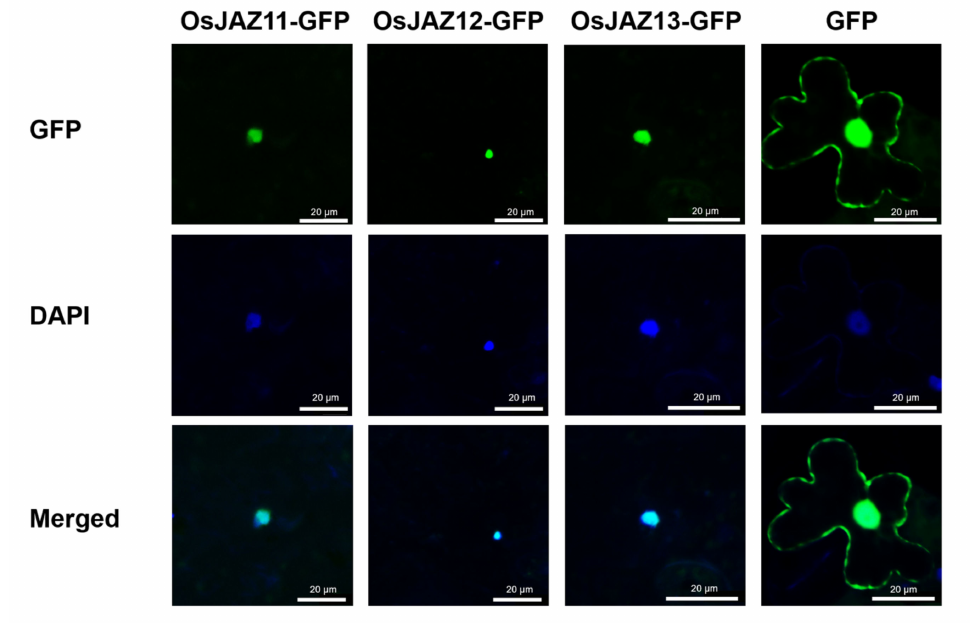
Figure 6. Subcellular protein localization. The fluorescence of the JAZ-GFP fusion protein in the OE plants in the nucleus was observed under a microscope. GFP-overexpressing transgenic plants were used as